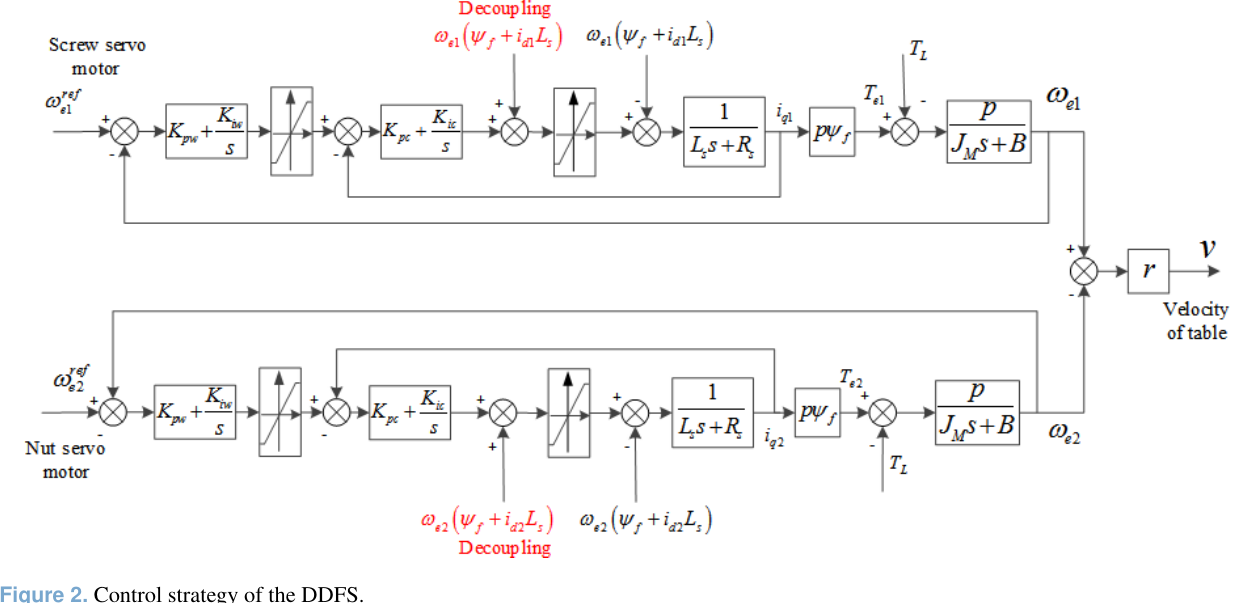
Figure 2. Control strategy of the